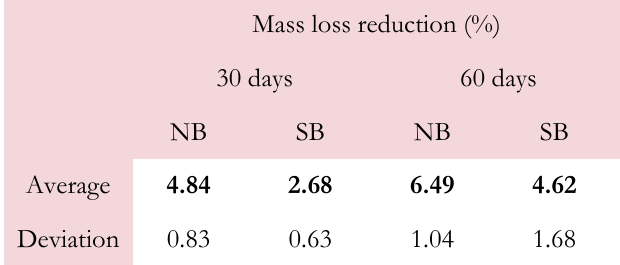
Table 3: Mass loss reduction.